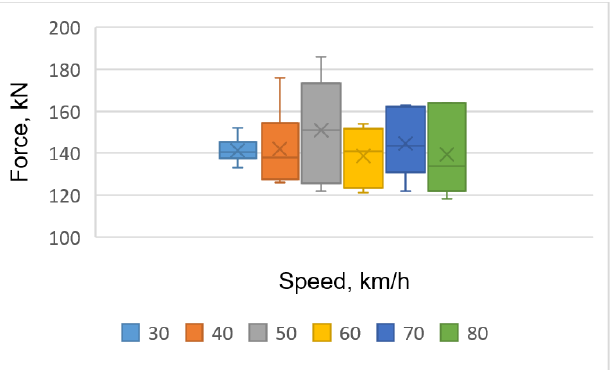
Figure 20. Maximal force values of loaded wagon (the second iteration).